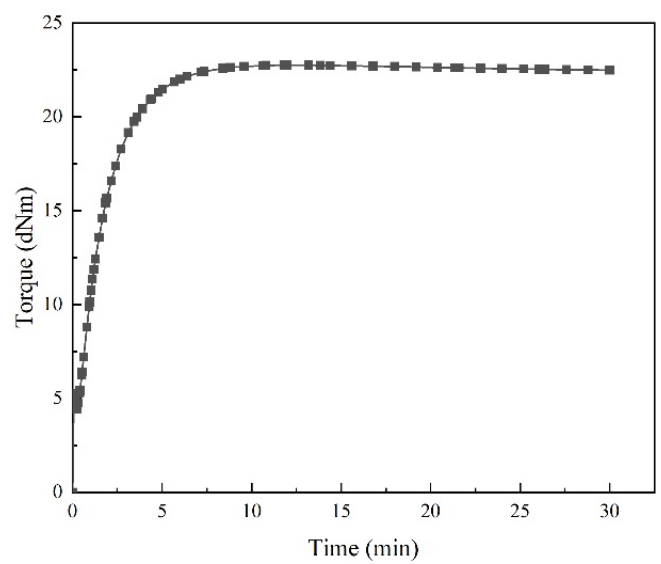
Figure 8. Vulcanization curve of HXNBR.